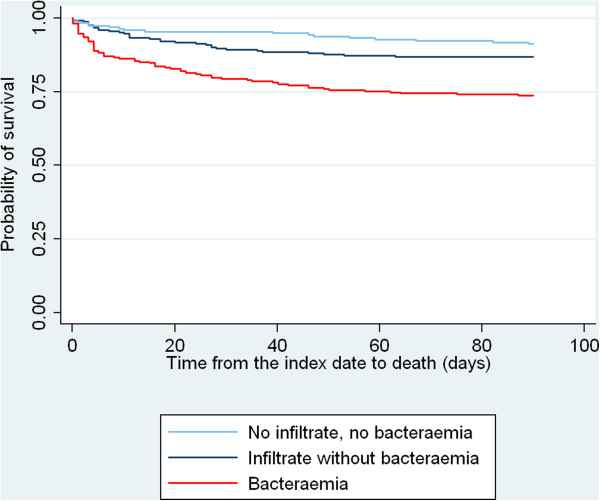
Kaplan-Meier survival curves for patients hospitalized with pneumococcal LRTI according to manifestation group. The numbers at risk represent the number of patients still at risk of death at a given time during the follow-up period. LRTI, lower respiratory tract infection.